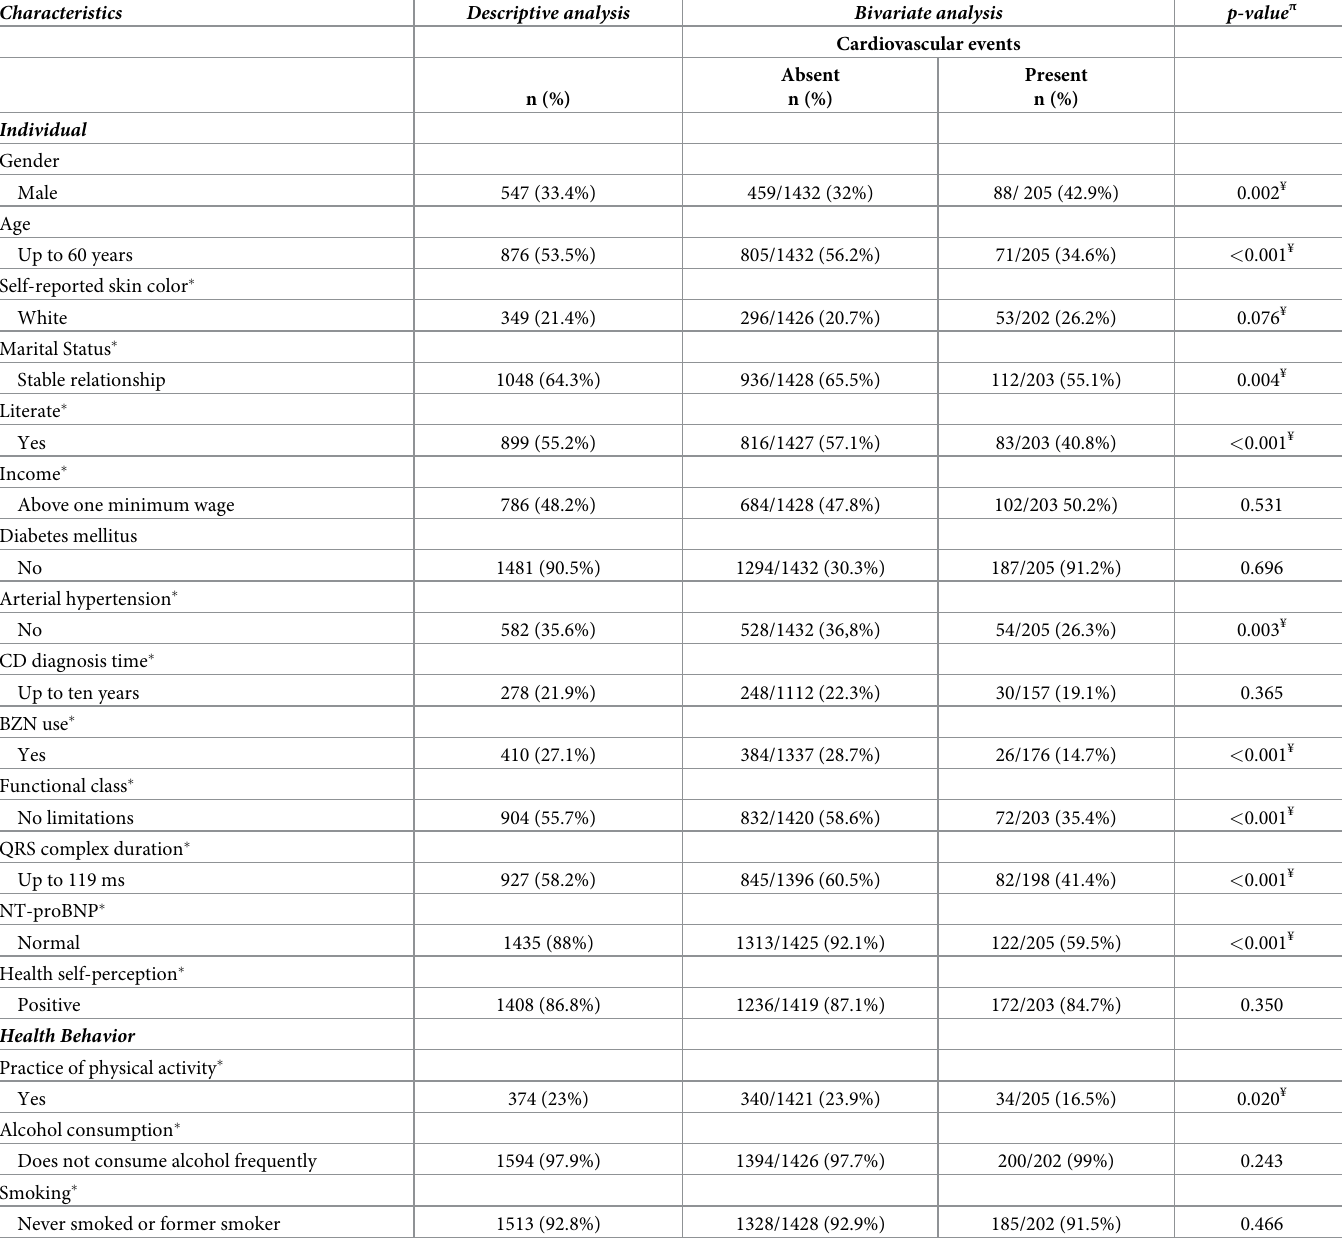
Table 2. Descriptive and bivariate analysis of individual socio-demographic, lifestyle, and health condition-related characteristics and their association with the occurrence of cardiovascular events over two years in Chagas Disease (CD) patients. Minas Gerais, Brazil (n =